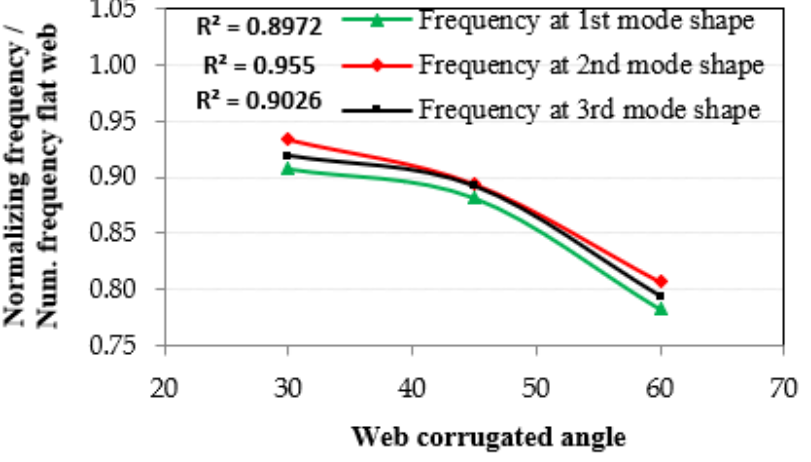
Figure 25. The relationship between normalized frequencies and the corrugated web angle.